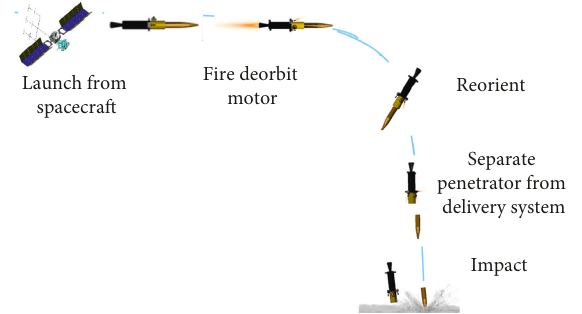
Figure 1: Working principle of the high-speed impact